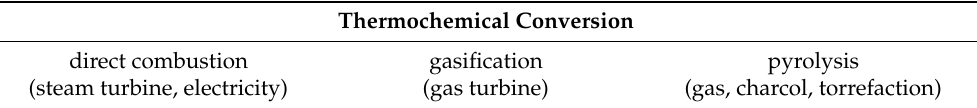
Table 2. Thermochemical conversion of biomass. Source: own elaboration based on [27]. Thermochemical Conversion direct